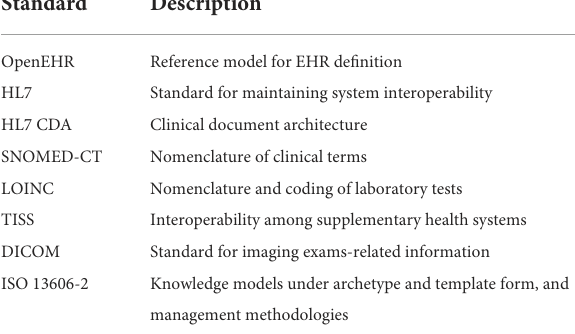
TABLE 1 Interoperability standards set forth in the Ministerial Order No. 2,073 of